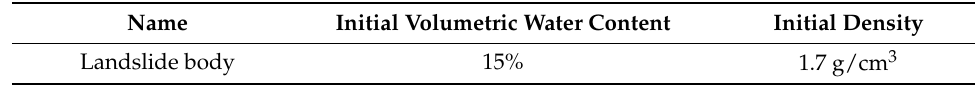
Table 1. Material properties of the landslide body.